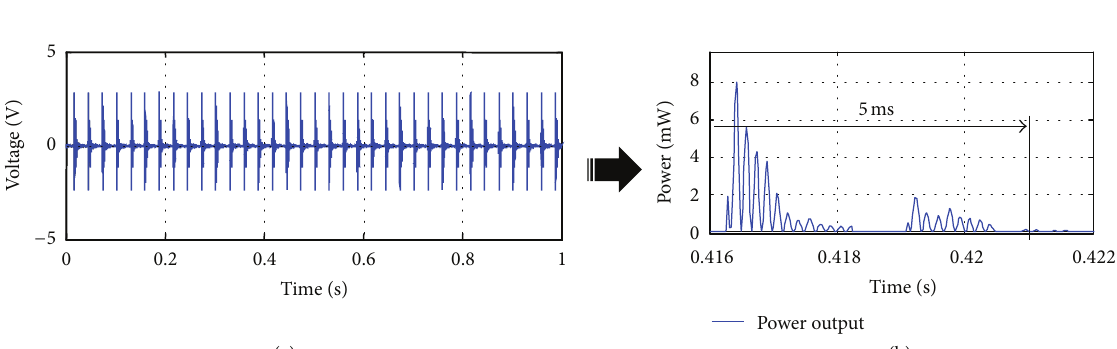
Figure 11: Experimental setup.